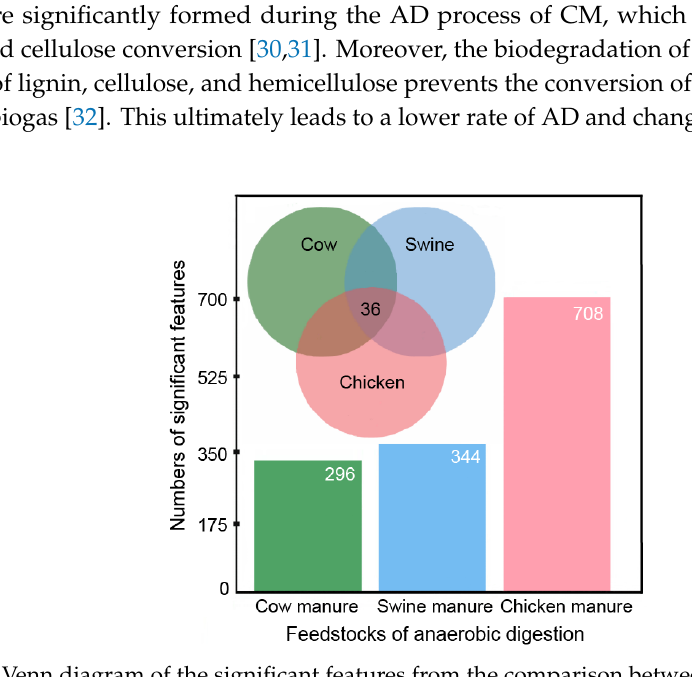
Figure 2. Venn diagram of the significant features from the comparison between manure types and their digestates (min FC ≥ 2, max p -value ≤ 0.05, max Intensity ≥ 0).